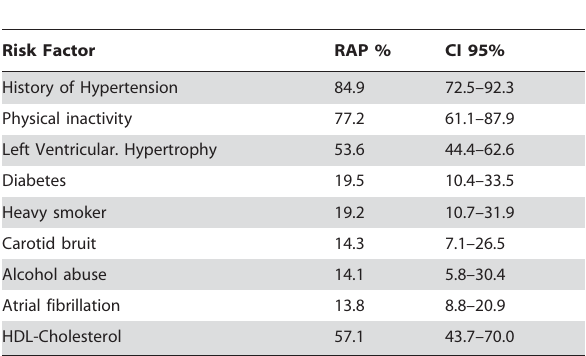
Table 2. PAR% for each risk factor for ischemic